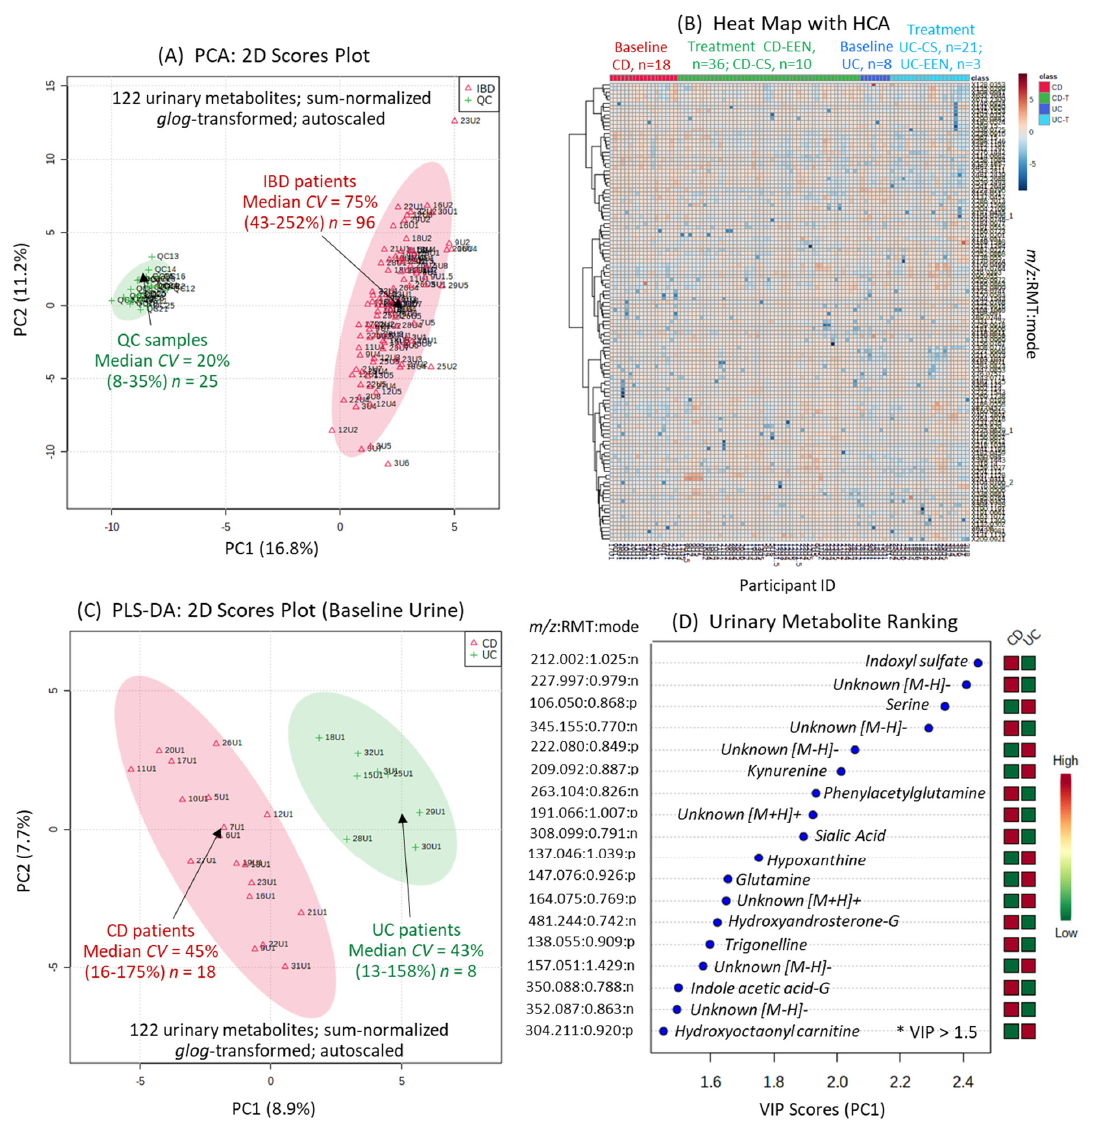
Figure 1. The urine metabolome of pediatric IBD patients by MSI ‐ CE ‐ MS prior to and following induction therapy via